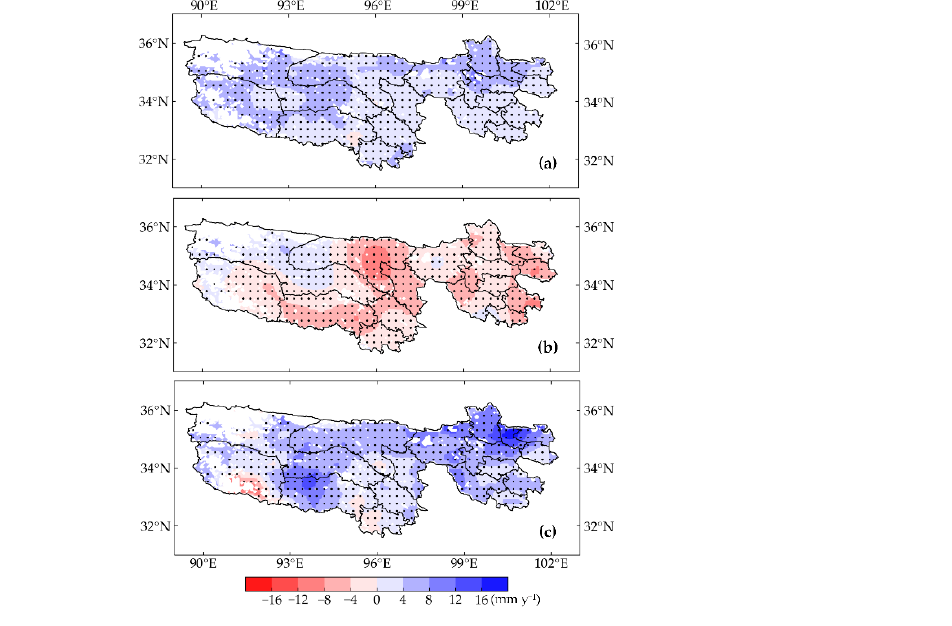
Figure 12. Spatial pattern of P trends from ( a ) 1982–2018, ( b ) 1982–1998, and ( c ) 1998–2018 in the TRHR. The black solid dots refer to grids with 95% confidence.